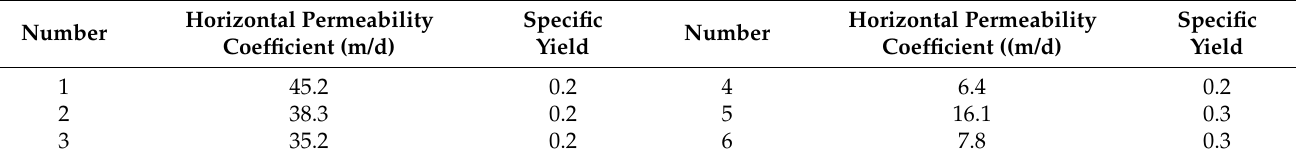
Figure 7. Parameter partitions. Table 2. Initial parameter values of the model.